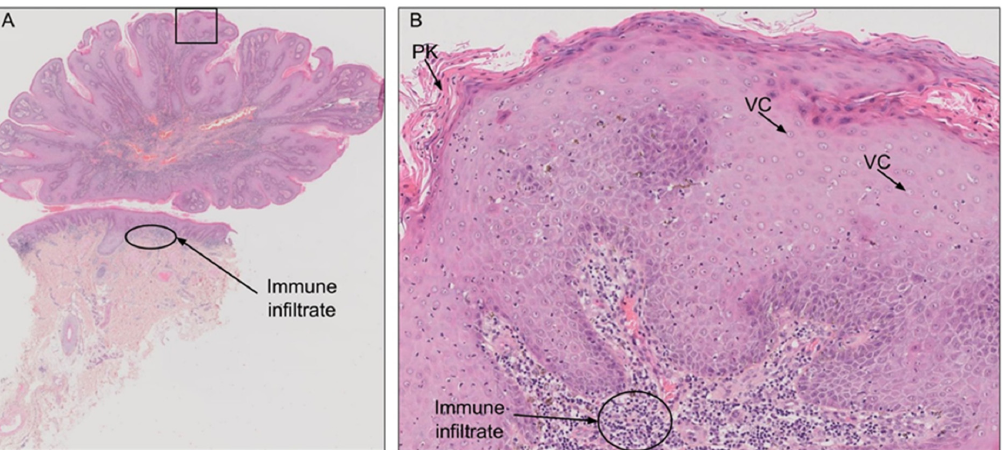
Figure 1. Hematoxylin and eosin staining of a penile Buschke-Lowenstein tumor (BLT). ( A ) BLT presents with a typical cauliflower shape, without invasion of the dermis. ( B ) Magnification of the indicated area from A. The histological features are typical of HPV infection, with numerous vacuolated cells (VC; koilocytosis) and parakeratosis (PK). Large immune infiltrates are visible in the dermis downstream from the lesion.